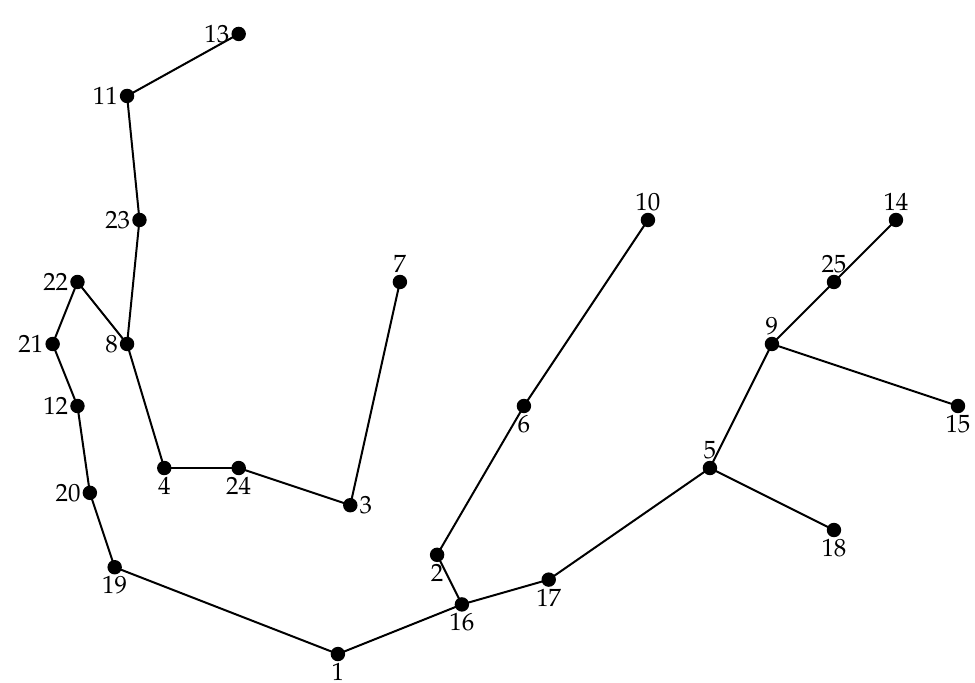
Figure 7. Alternative solution for routes of the 25-bus test feeder.